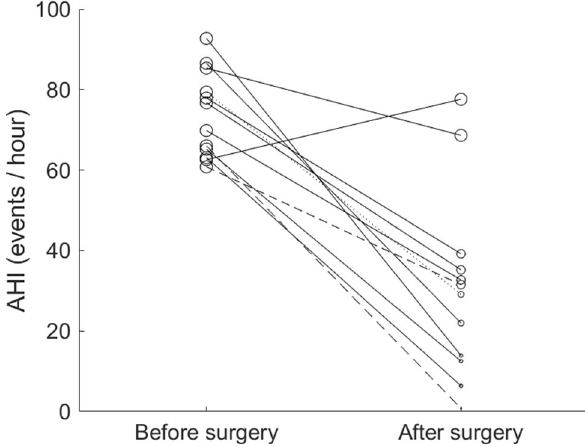
Figure 3. Individual change of apnea–hypopnea index (AHI) after the surgery. Dotted, dashed, and solid line: anatomical stage 1, 2, and 3, respectively. Very big, big, median, small, and none circle: in the category of very severe, severe, moderate, mild obstructive sleep apnea (OSA), and normal,